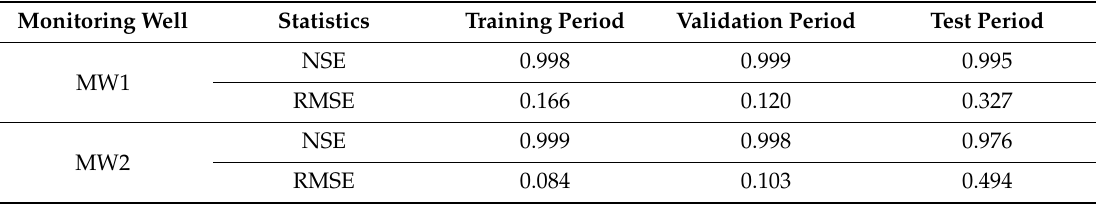
Table 4. Modeling performance of LSTM for the one-day groundwater level